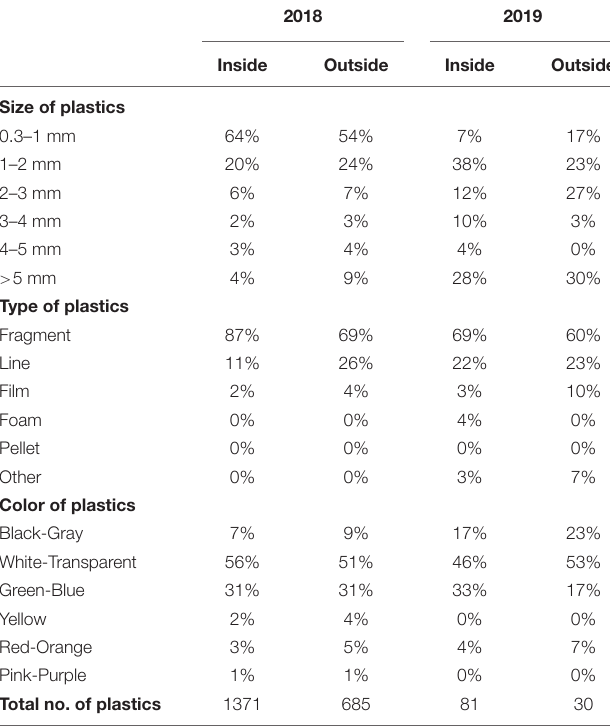
TABLE 2 | The characteristics of the mesoplastics ( > 5 mm) and microplastics ( < 5 mm) found inside and outside the